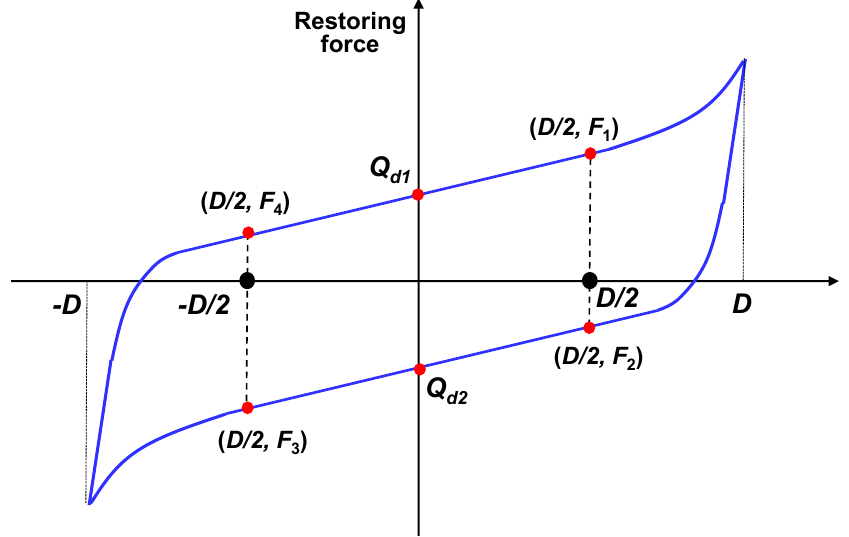
Figure 11. Illustration of the ASCE method for determination of tangential sti ff ness and characteristic strength.